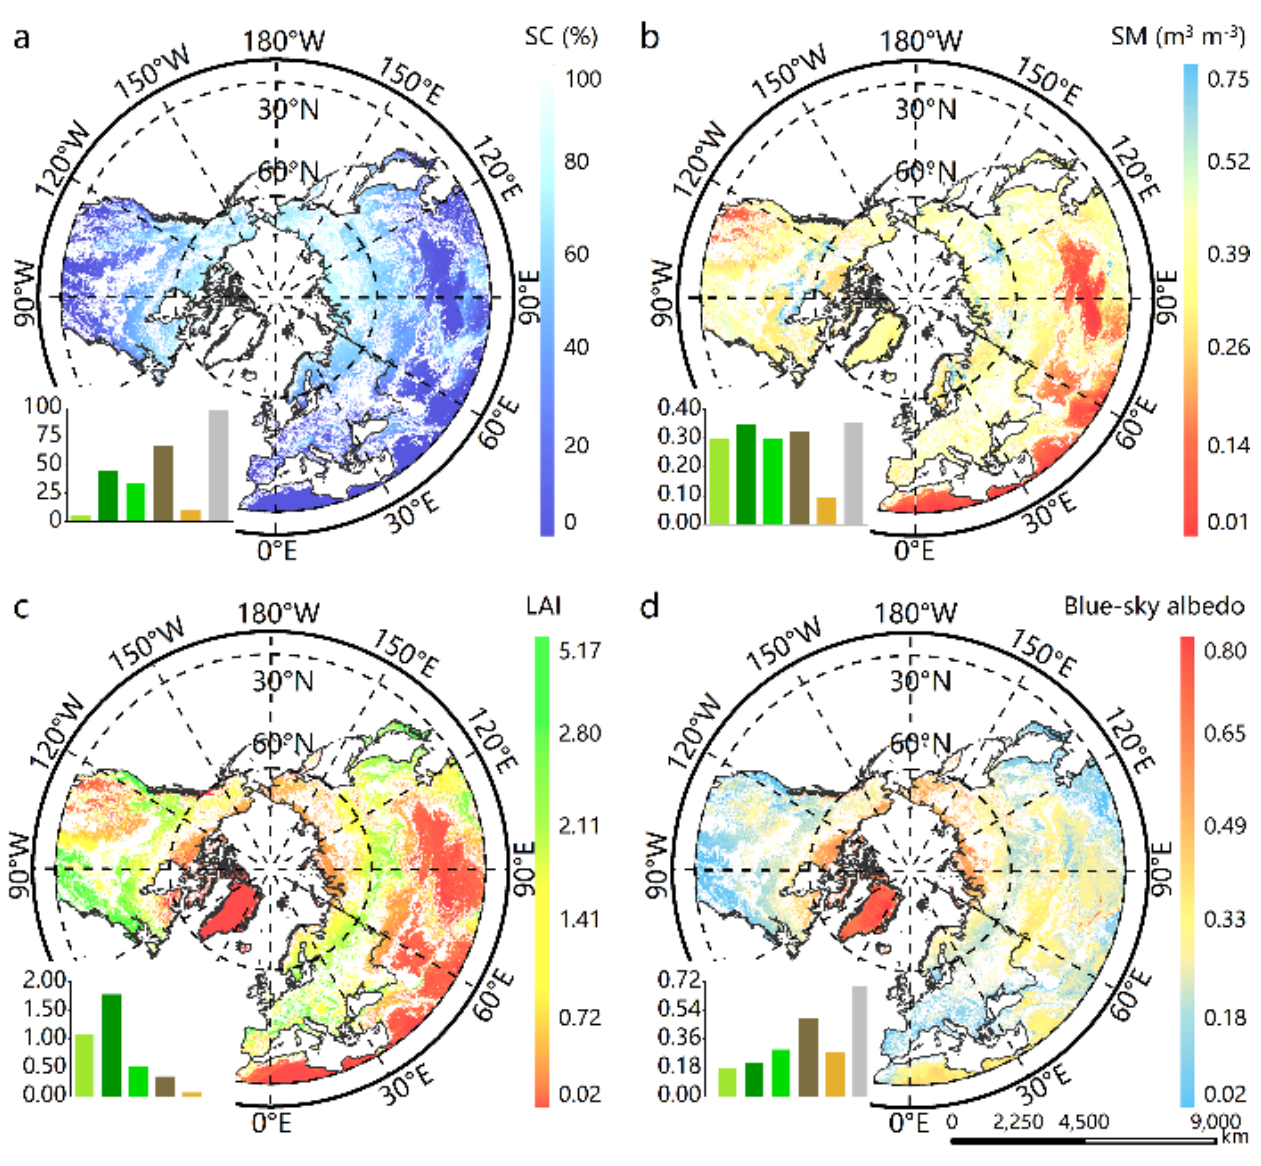
Figure 2. Spatial distribution of 34 year average SC(a), SM(b), LAI(c) and blue-sky albedo(d). Insets at the bottom left show the 34 year average of different land cover types in (a), (b), (c) and (d), with bar colors corresponding to the colors in the legend in the Figure 1 (a).